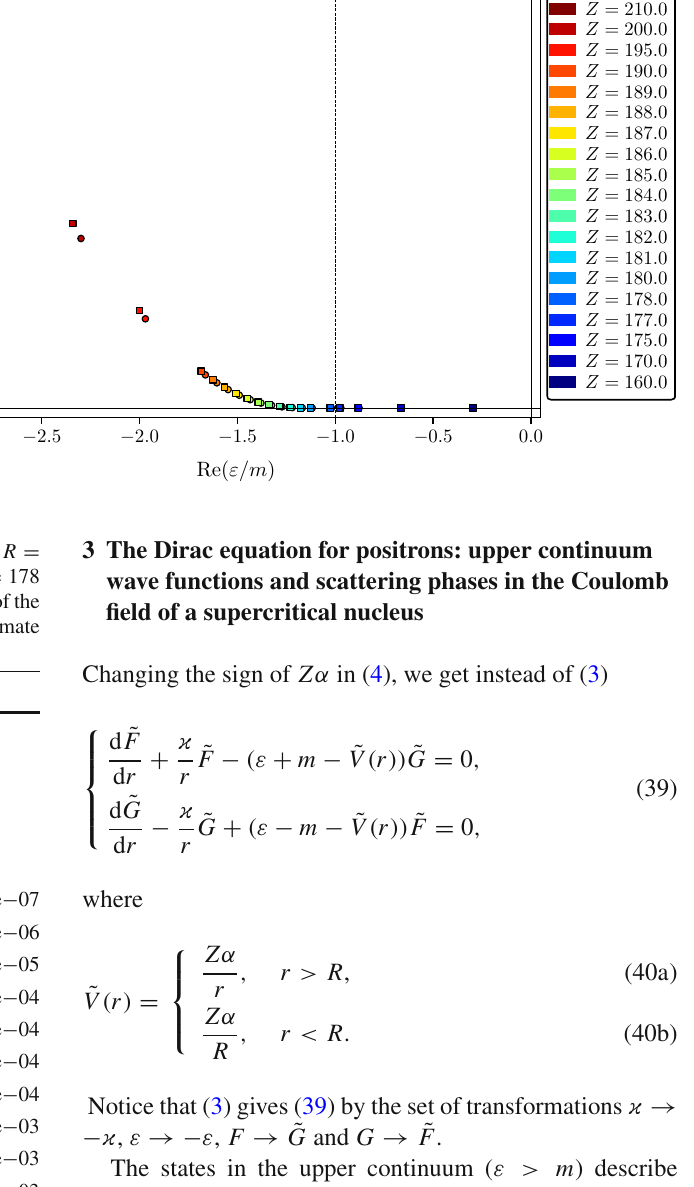
Z = 210 . 0 Z = 200 . 0